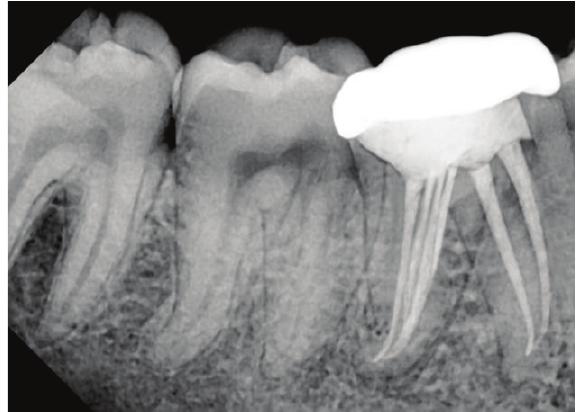
Figure 3: 15-month follow-up